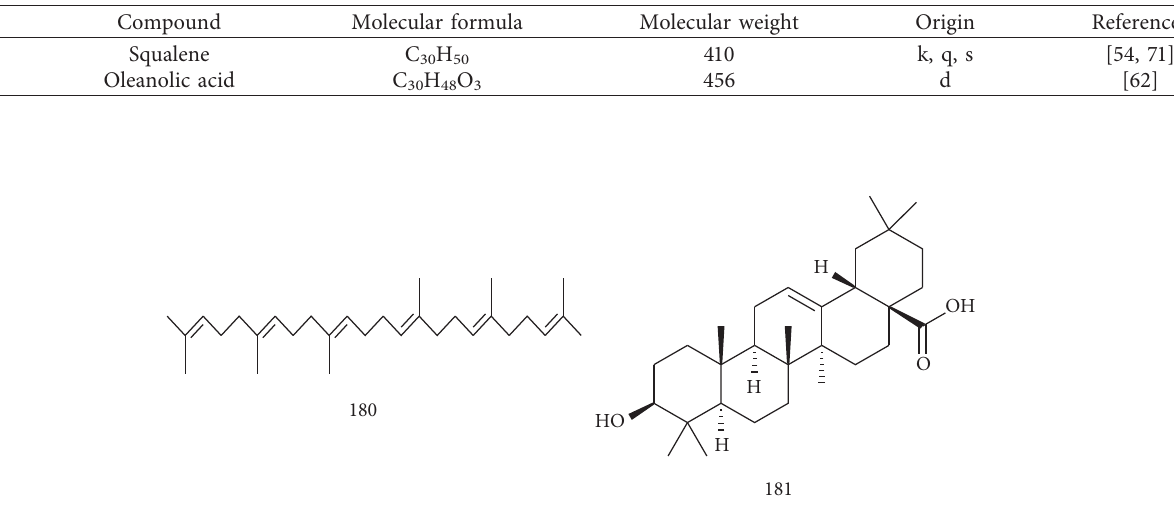
Figure 5: The structures of triterpenes from Cinnamomum